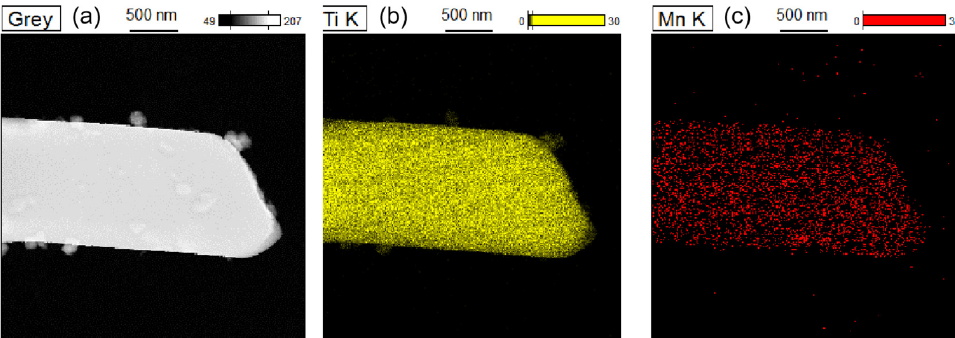
Figure 12. EDS mapping of the fresh MnTi catalyst ( a ) TEM images of MnTi catalyst, ( b ) Ti element distribution, and ( c ) Mn element distribution.